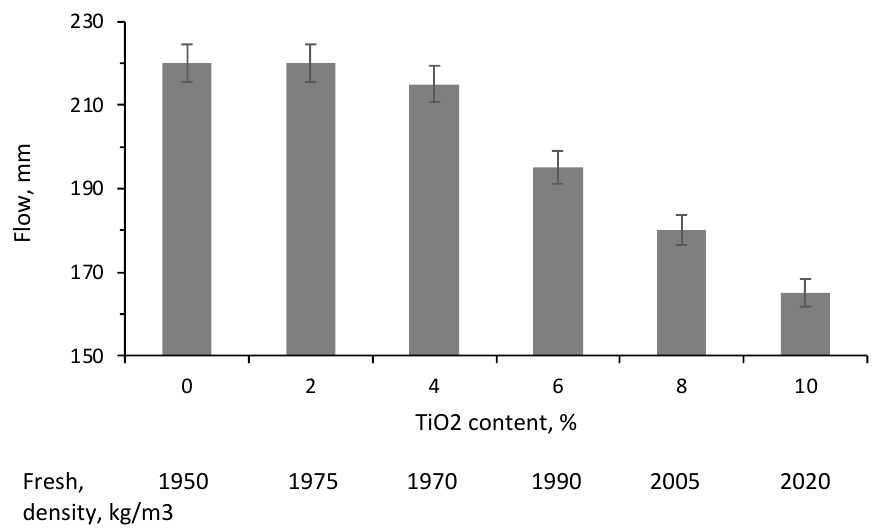
Figure 4. Effect of TiO 2 on flow and density (i.e., fresh) of cement slurries.